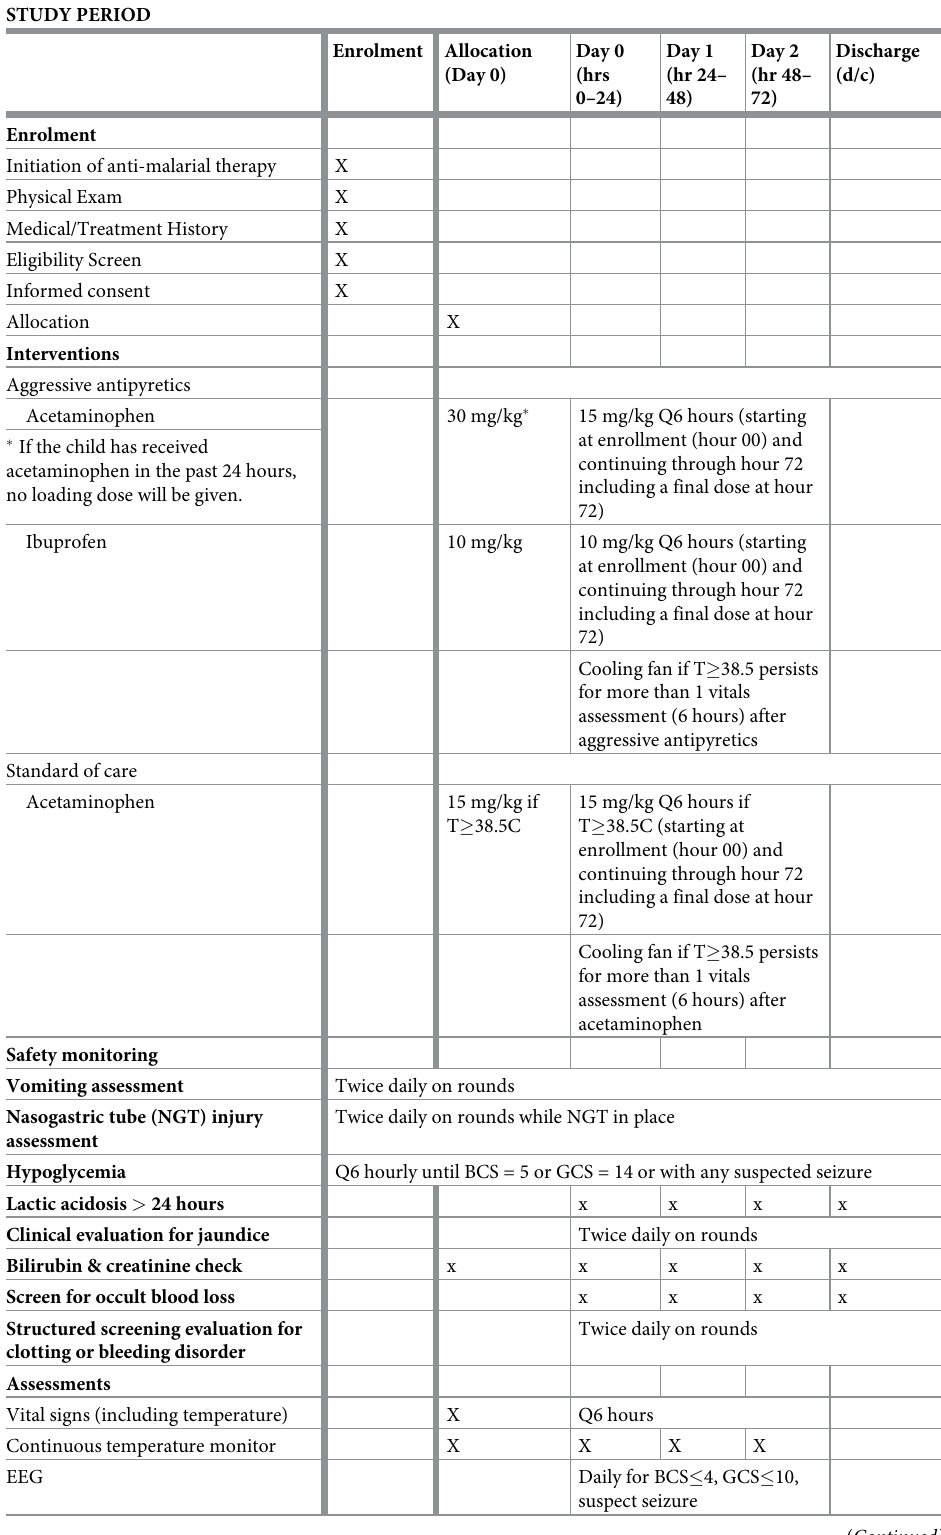
Table 4. Participant